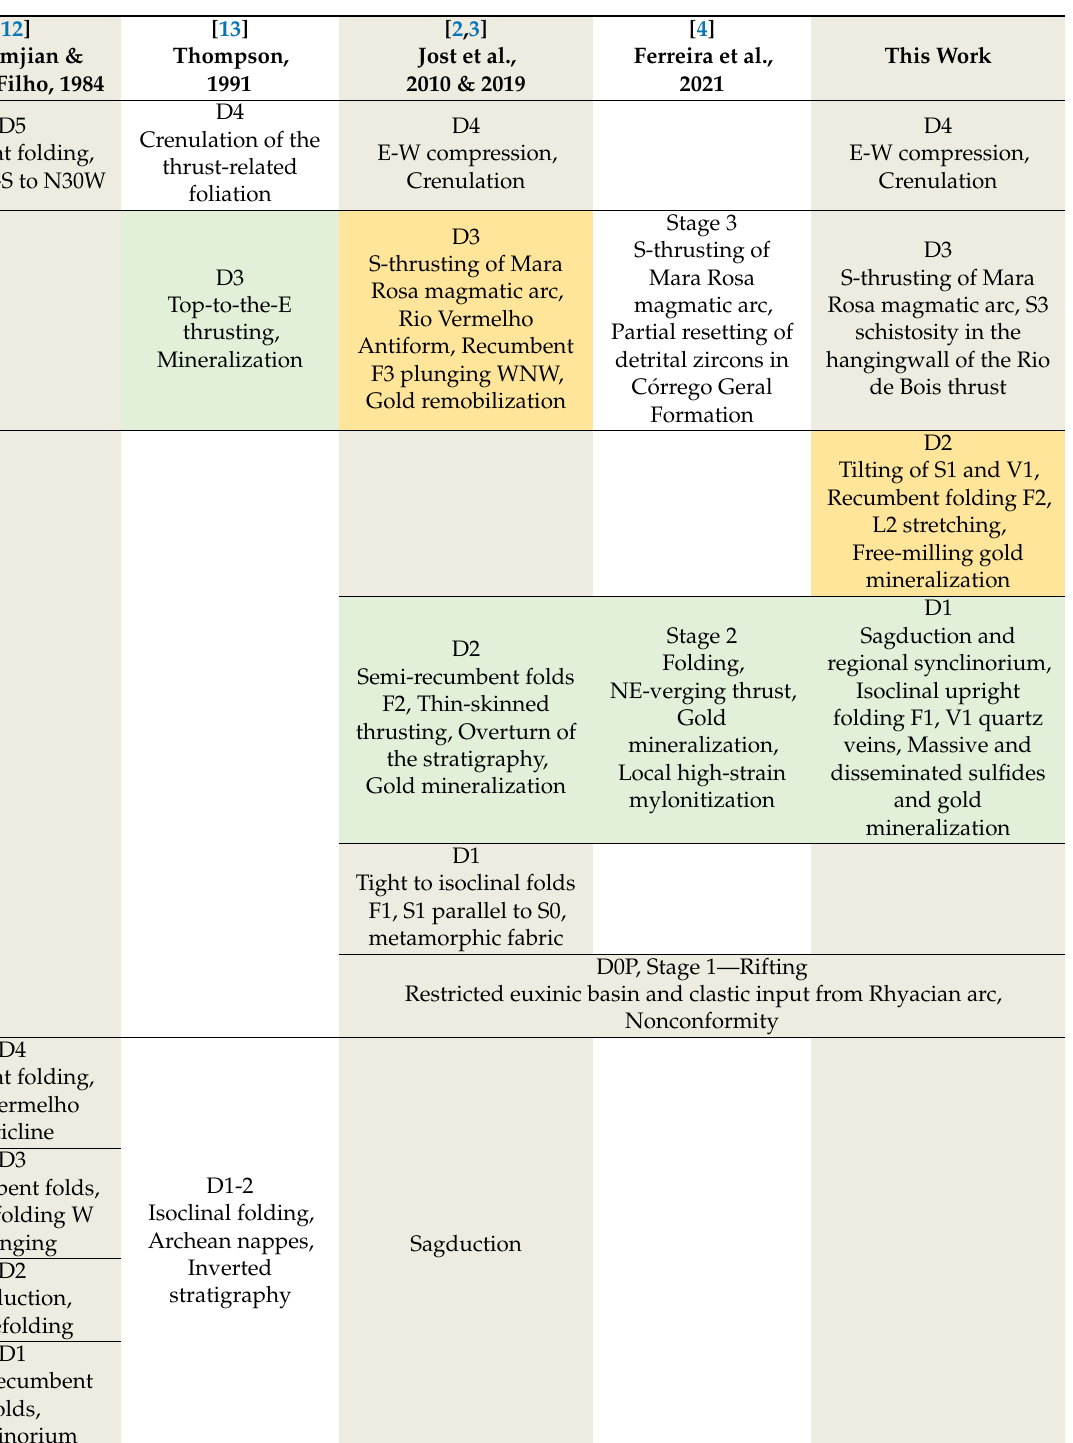
Table 1. Summary of presented structural schemes. Absolute times not provided because of a paucity of geochronolog- ical data related to deformation. D0A—deposition of the Archean extrusives; D0P—deposition of the Paleoproterozoic basin. Ages of D0A and D0P are provided in the Chapter 7. Green background—gold in sulfides mineralization; Yellow background—free milling gold